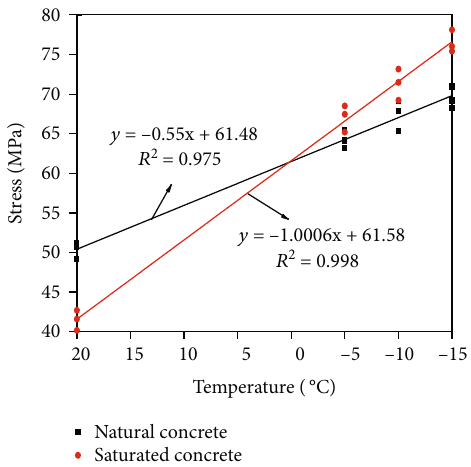
Figure 8: Relationship between dynamic strength and temperature of saturated